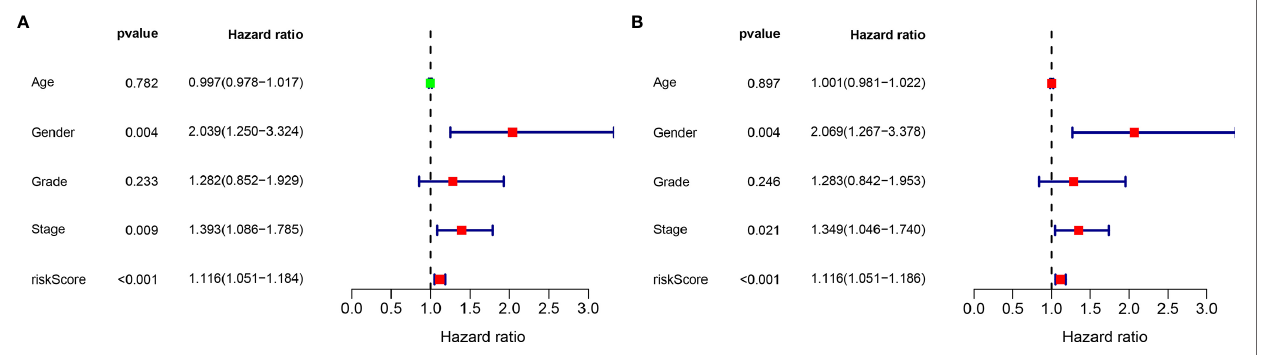
FIGURE 8 | Validation of the independence of the m6A-related lncRNA signature in DFS through the Univariate cox regression analysis (A) and Multivariate cox regression analysis (B) .